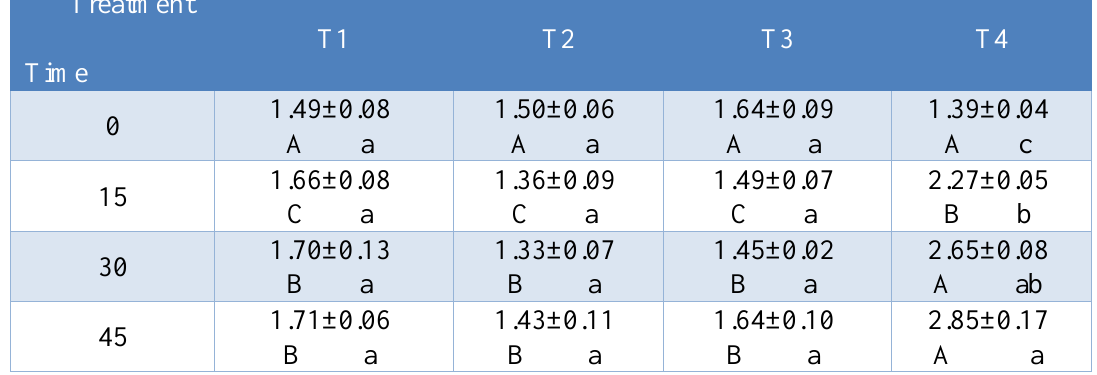
Table, 7: Effects of Salvia Officinal's SO) and Salvia Officinal's Silver Nanoparticles (SOSNP) on serum uric acid concentration (mg/dl) in normal and methotrexate (MTX) treated